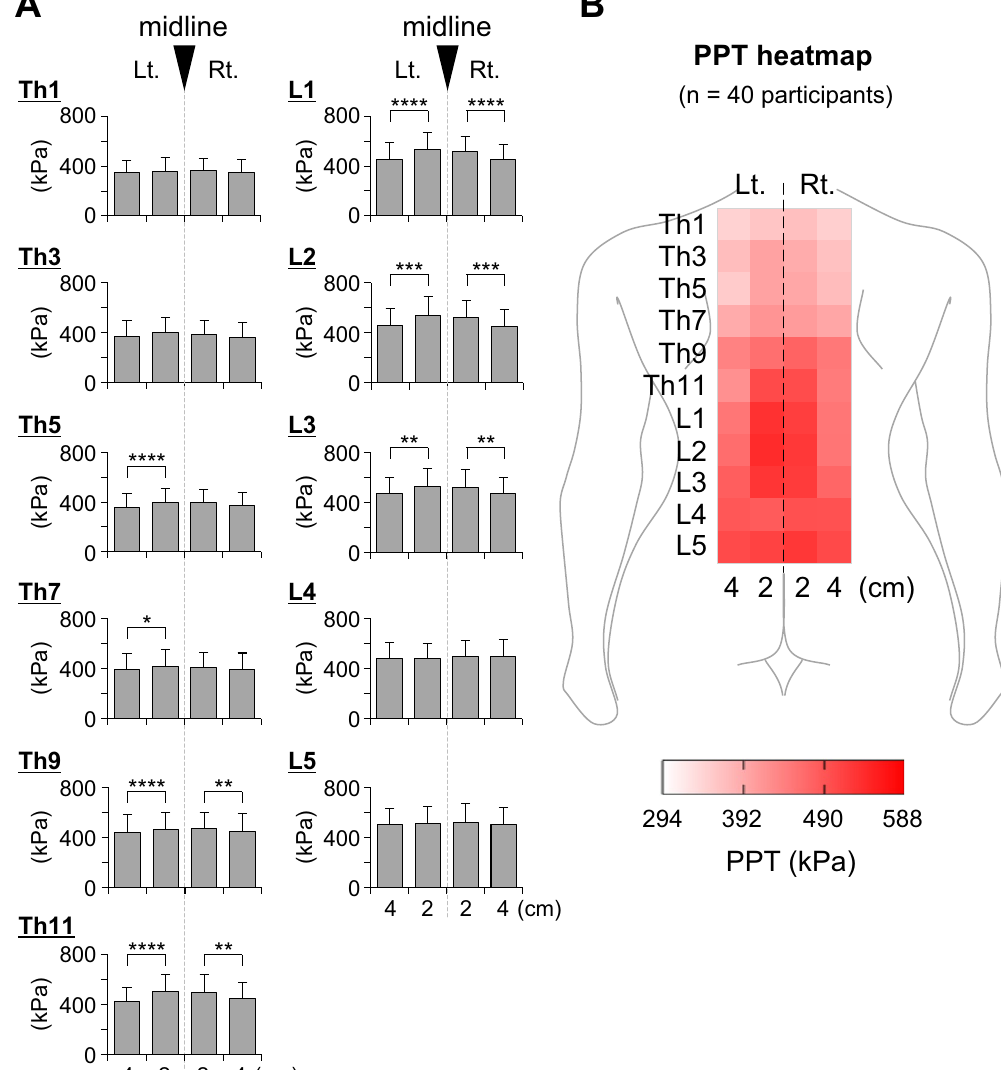
Figure 3. Pressure pain threshold (PPT) of paraspinal muscles in participants without LC. A. PPT measured in the thoracolumbar area (2 and 4 cm apart from midline vertebrae at the spinal segments Th1, Th3, Th5, Th7, Th9, Th11, L1, L2, L3, L4, and L5; n = 40 participants). See Supplementary Table 1 for detailed PPT values. Note tendencies for higher PPTs in lumbar compared with thoracic segments, and in muscles 2 cm apart from the vertebrae compared to those 4 cm at segments Th5–L3 (*p < 0.05, **p < 0.01, ***p < 0.001, and ****p < 0.0001, Friedman test followed by Dunn’s multiple comparison test). No significant differences in PPTs were observed between the left and the right side in any spinal segments examined (left 2 cm vs. right 2 cm and left 4 cm vs. right 4 cm, p > 0.05, Friedman test followed by Dunn’s multiple comparison test). B. A heatmap image of the mean PPTs obtained in the measurement in A . Mean PPTs ranged from 294 to 588